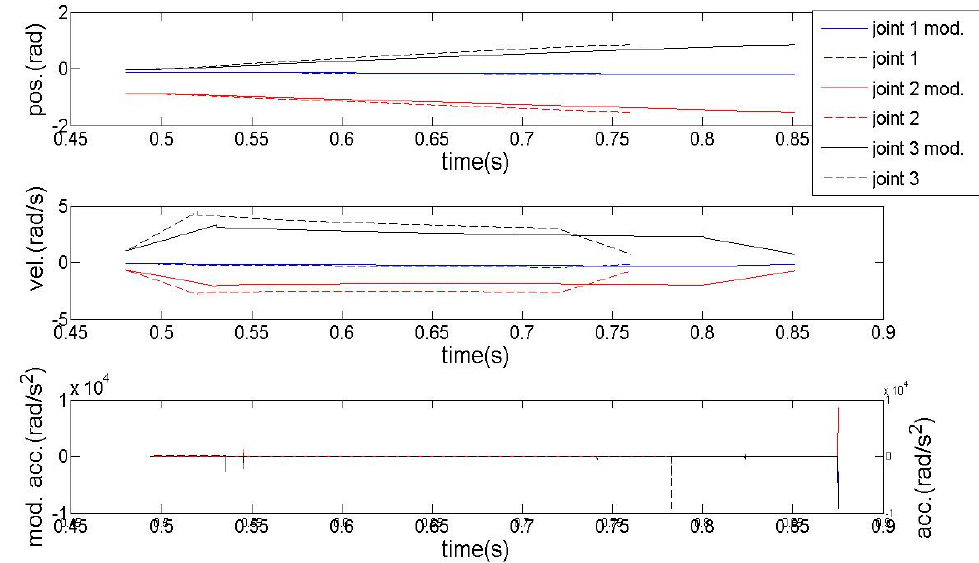
Figure 4. The local joint trajectories of first three joints (Here, pos., vel., acc., mod. are the abbreviation of position, velocity, acceleration and modified, respectively.). Table 4. Comparisons of joint velocities and accelerations.